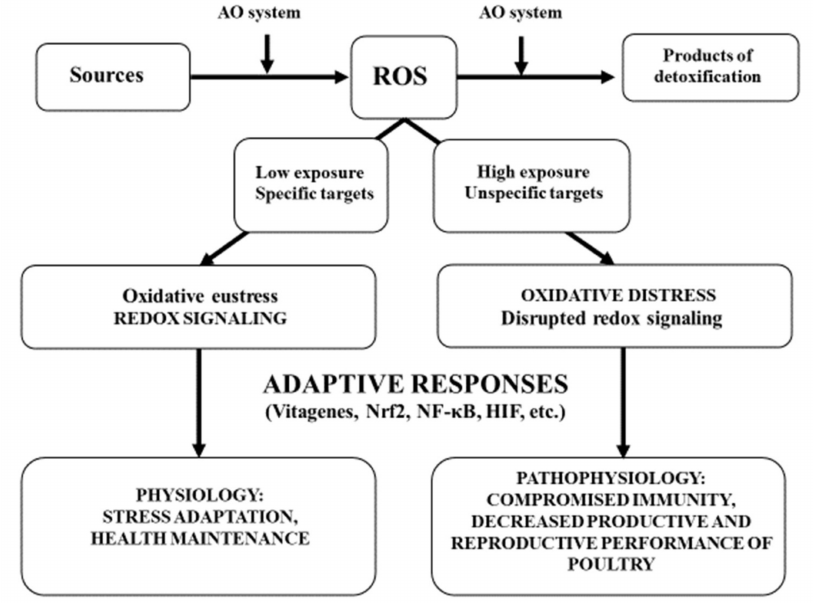
Figure 2. Oxidative stress and adaptive responses (adapted from Reference [99] with